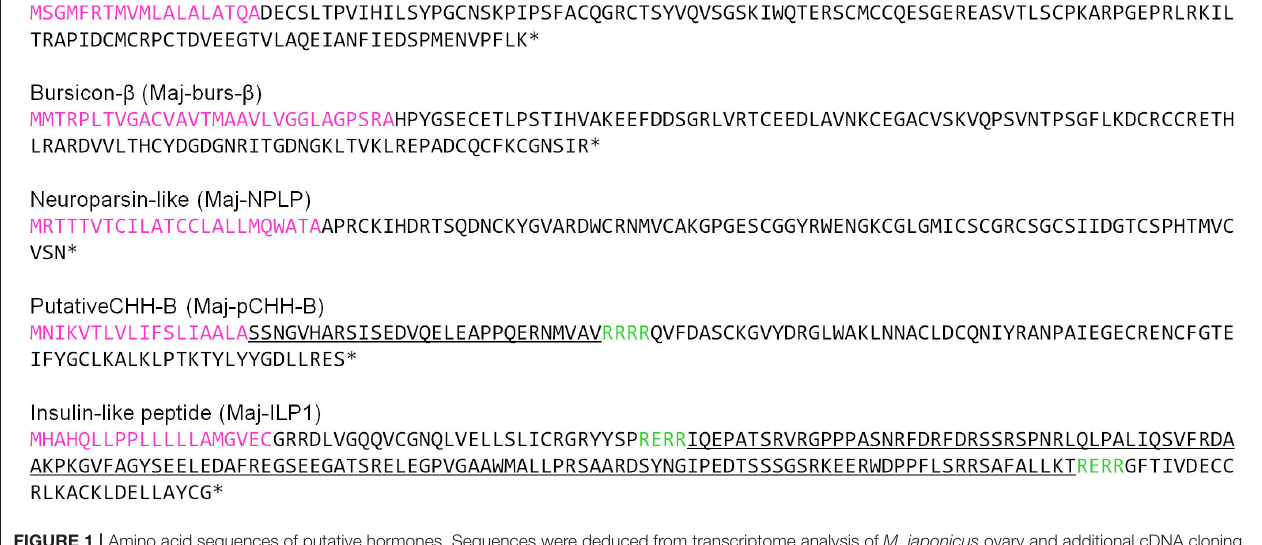
FIGURE 1 | Amino acid sequences of putative hormones. Sequences were deduced from transcriptome analysis of M. japonicus ovary and additional cDNA cloning. Sequences shown in magenta and green represent the predicted signal sequences and cleavage sites, respectively. Underlined sequences represent CPRP in Maj-pCHH-B and C-peptide in Maj-ILP1,